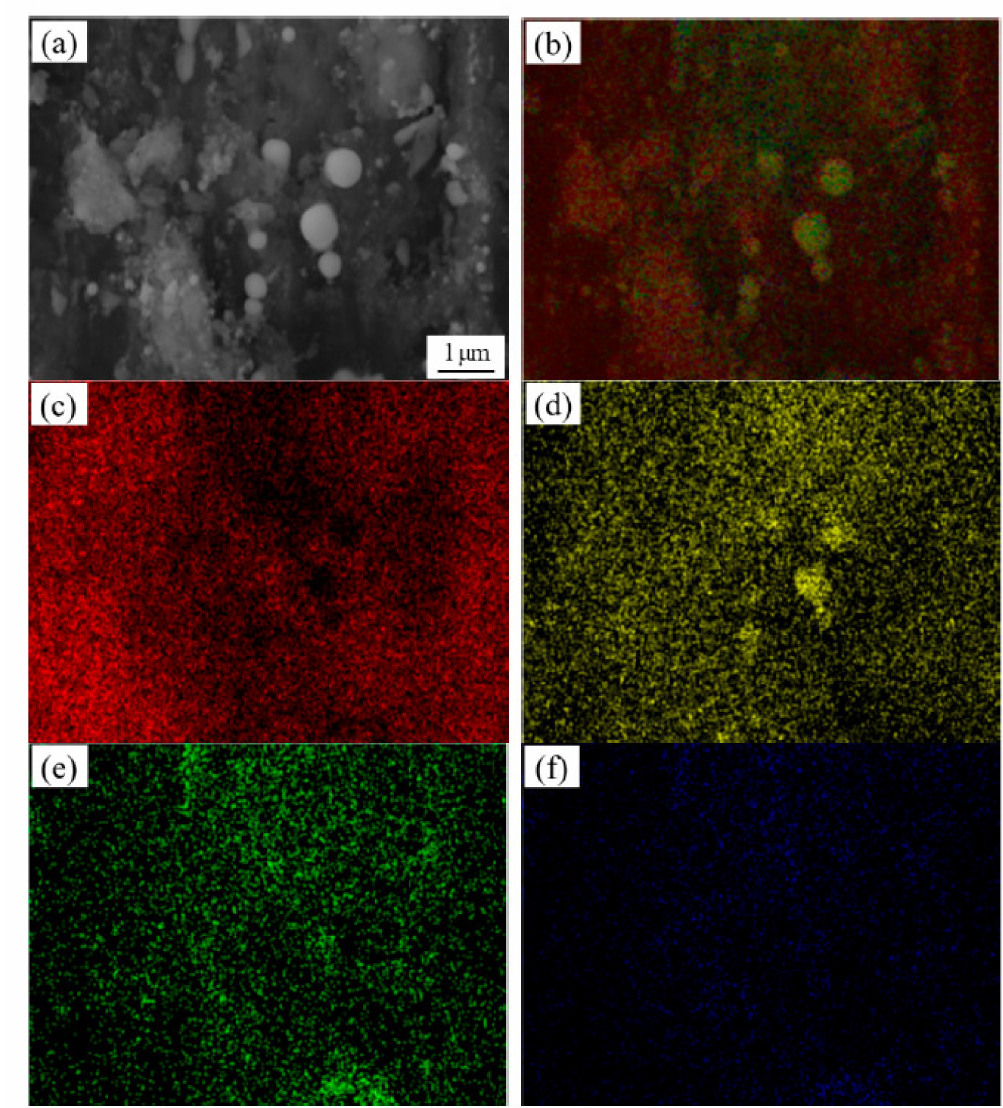
Figure 3. Scans of 80 wt.%Al-20 wt.%GIS (6:3:1) EDS surface of the alloy: ( a ) SEM diagram of the aluminum alloy at 10,000 × , ( b ) EDS hierarchical image, ( c ) Al layer, ( d ) Ga layer, ( e ) In layer, and ( f ) Sn